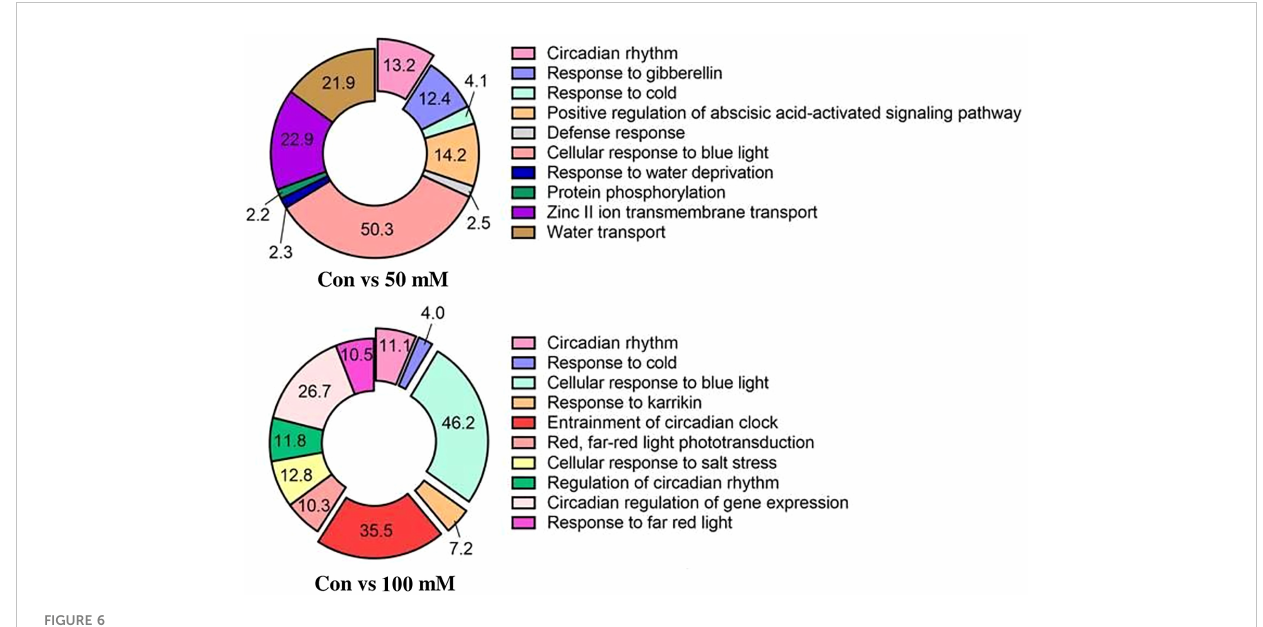
FIGURE 6 Gene ontology analysis: biological processes for NaCl concentrations ( n =